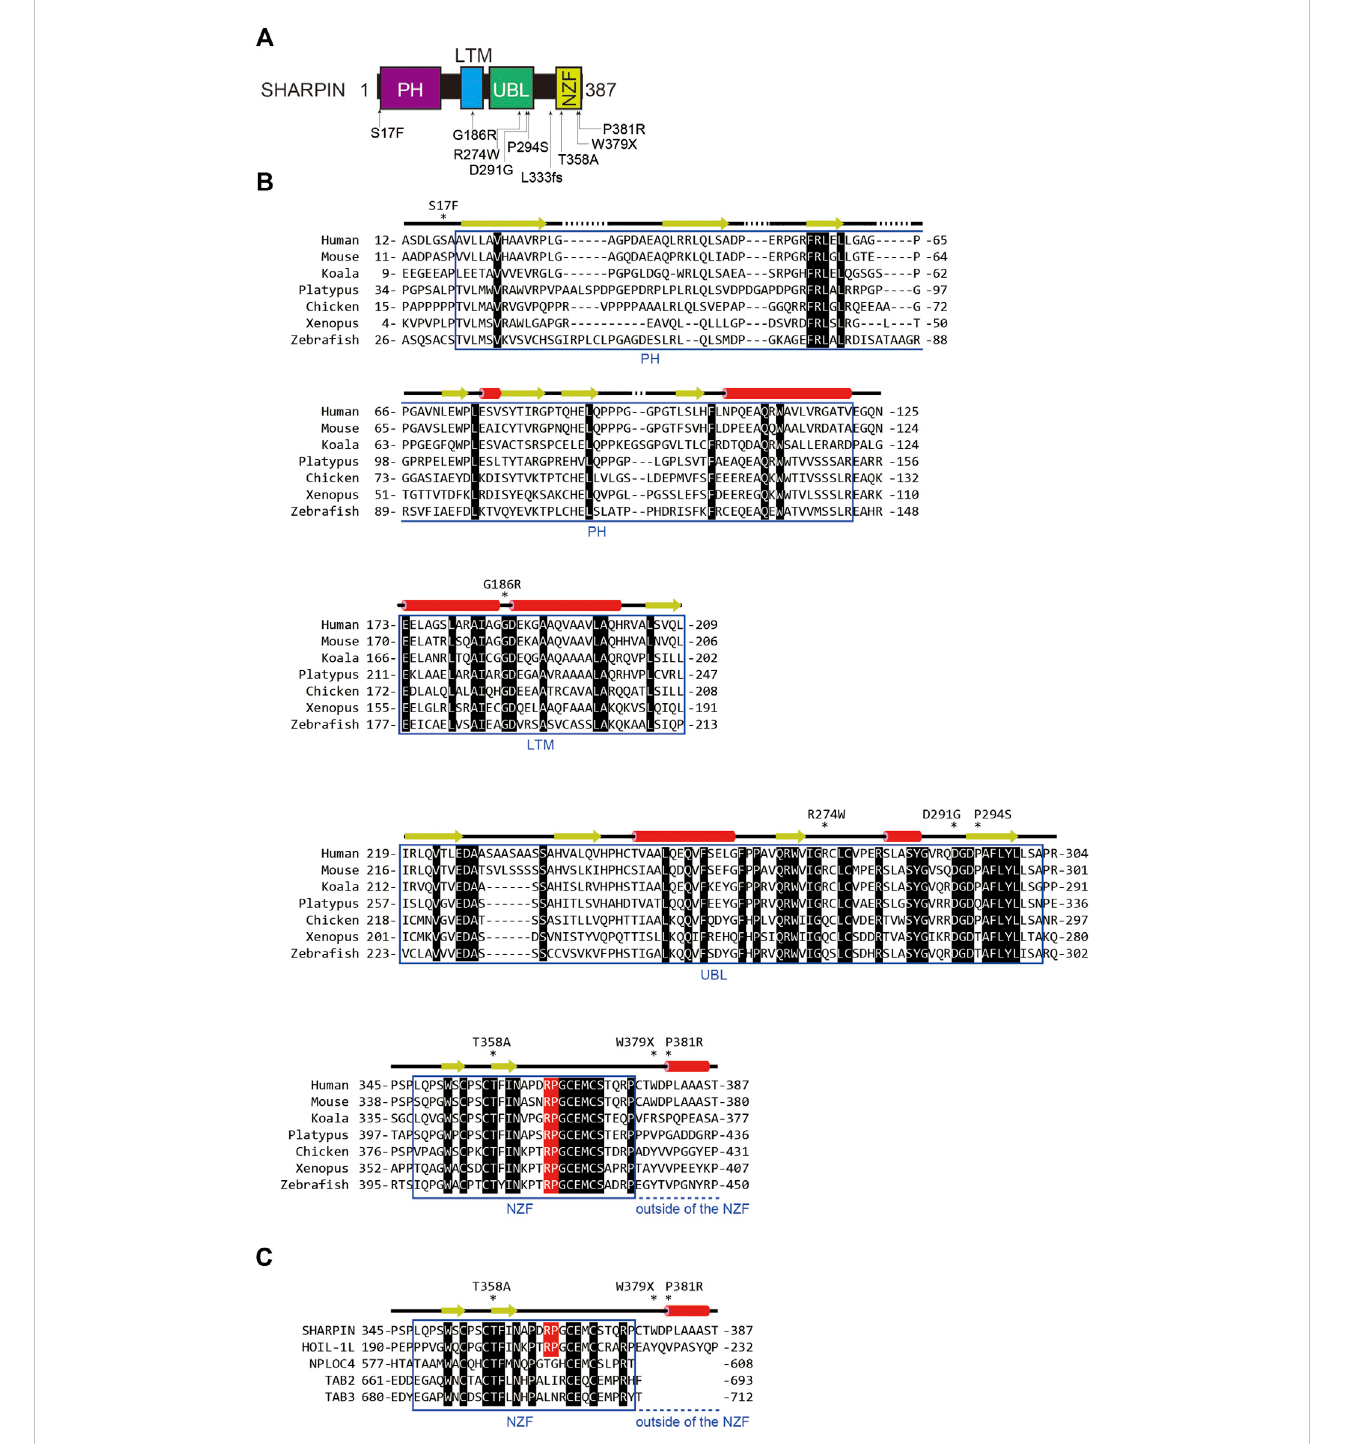
FIGURE 2 AD-associated SNP sites and the amino acid alignment of SHARPINs from various species. (A) AD-associated SNPs are mapped on the domain structure of SHARPIN. (B) The amino acid sequences of SHARPINs from various species are aligned. Residues conserved in all species are shown by white letters on a black background. The Arg-Pro sequences conserved between the NZF domains of HOIL-1L and SHARPIN are highlighted by a red background. Arrows: β - sheet; red cylinders: α -helix. (C) The NZF domain of SHARPIN showed the highest similarity with that of HOIL-1L. The amino acid sequences of various ubiquitin-binding NZF domains are aligned and structurally characterized as in (B)